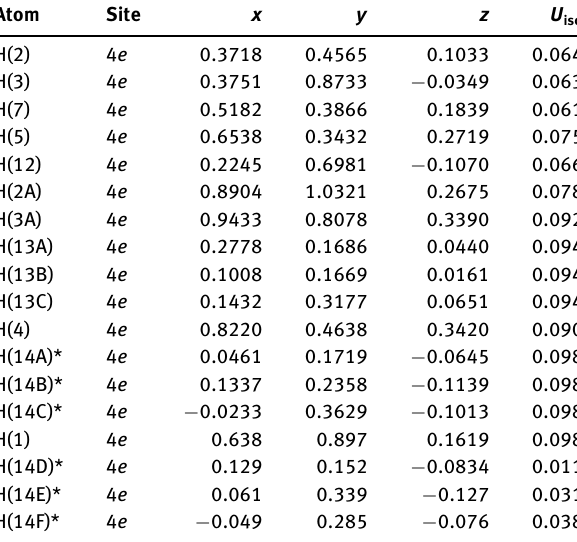
Table 2: Fractional atomic coordinates and isotropic or equivalent isotropic displacement parameters (Å 2